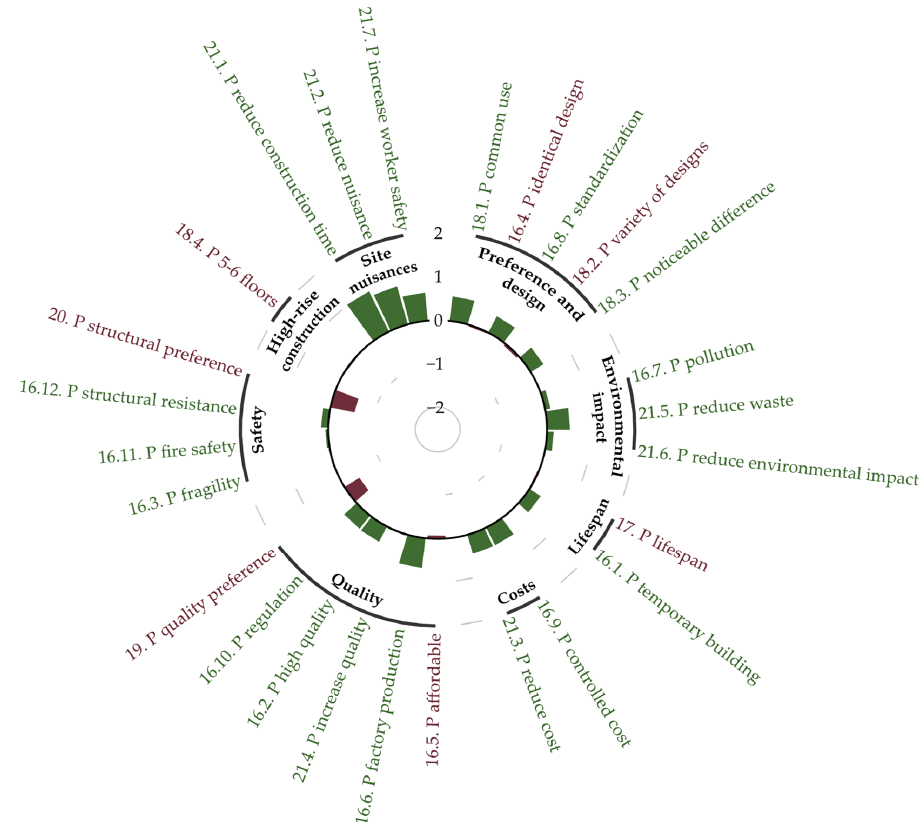
Figure 8. Average response profile of the sample about light-frame wood prefabrication. Items in green show a positive perception, while items in red a negative perception. green show a positive perception, while items in red a negative